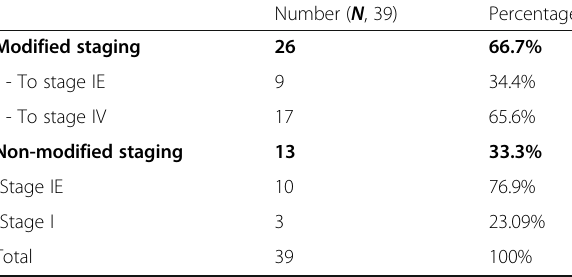
Table 3 Effect of fused PET/CT study in modification of the staging of